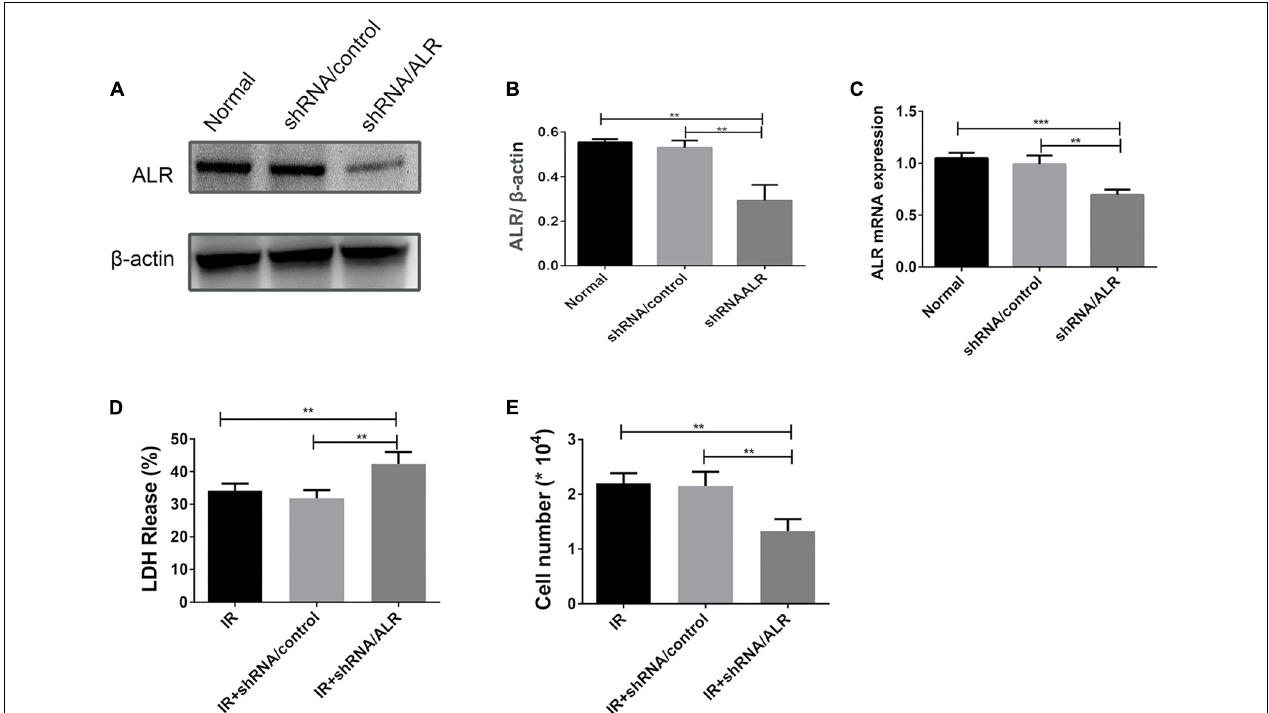
FIGURE 3 | Silencing of augmenter of liver regeneration (ALR) increases HK-2 cells Susceptibility to ischemia–reperfusion (I/R) treatment. (A,B) Immunoblot analysis and quantification of ALR. (C) The expression of ALR messenger RNA (mRNA) was measured via quantitative real-time PCR (qPCR). Data represent means ± SD. n = 3. ** p < 0.01, *** p < 0.001. (D) The lactate dehydrogenase (LDH) released in the supernatant of cultured cells was measured at the indicated time. A significant increase was observed in the short hairpin (shRNA)/ALR group when compared with the shRNA/control group or I/R group. (E) The cell number was counted in three groups at I6R12. The cell number of shRNA/ALR group clearly decreased after I/R. Data represent means ± SD. n = 4. ** p <